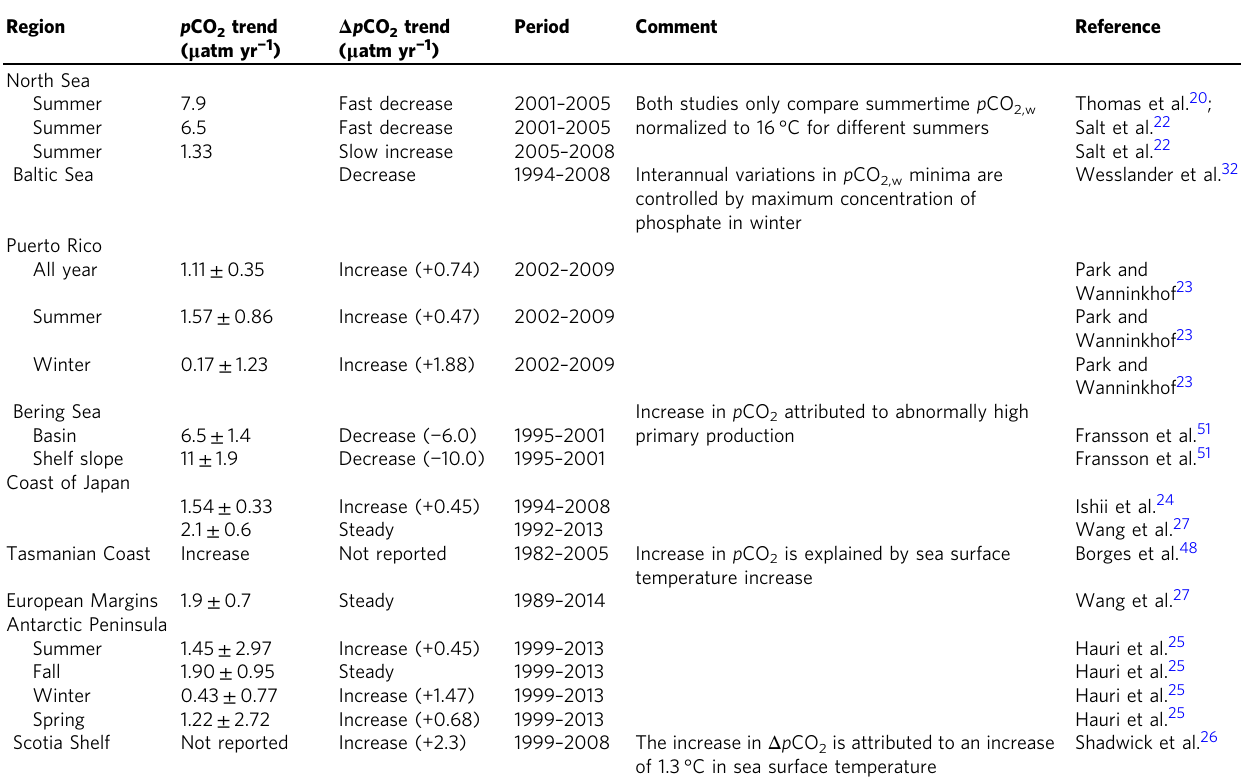
Table 2 Rates of change in p CO 2 and corresponding rate of change in Δ p CO 2 in different regions reported in the literature